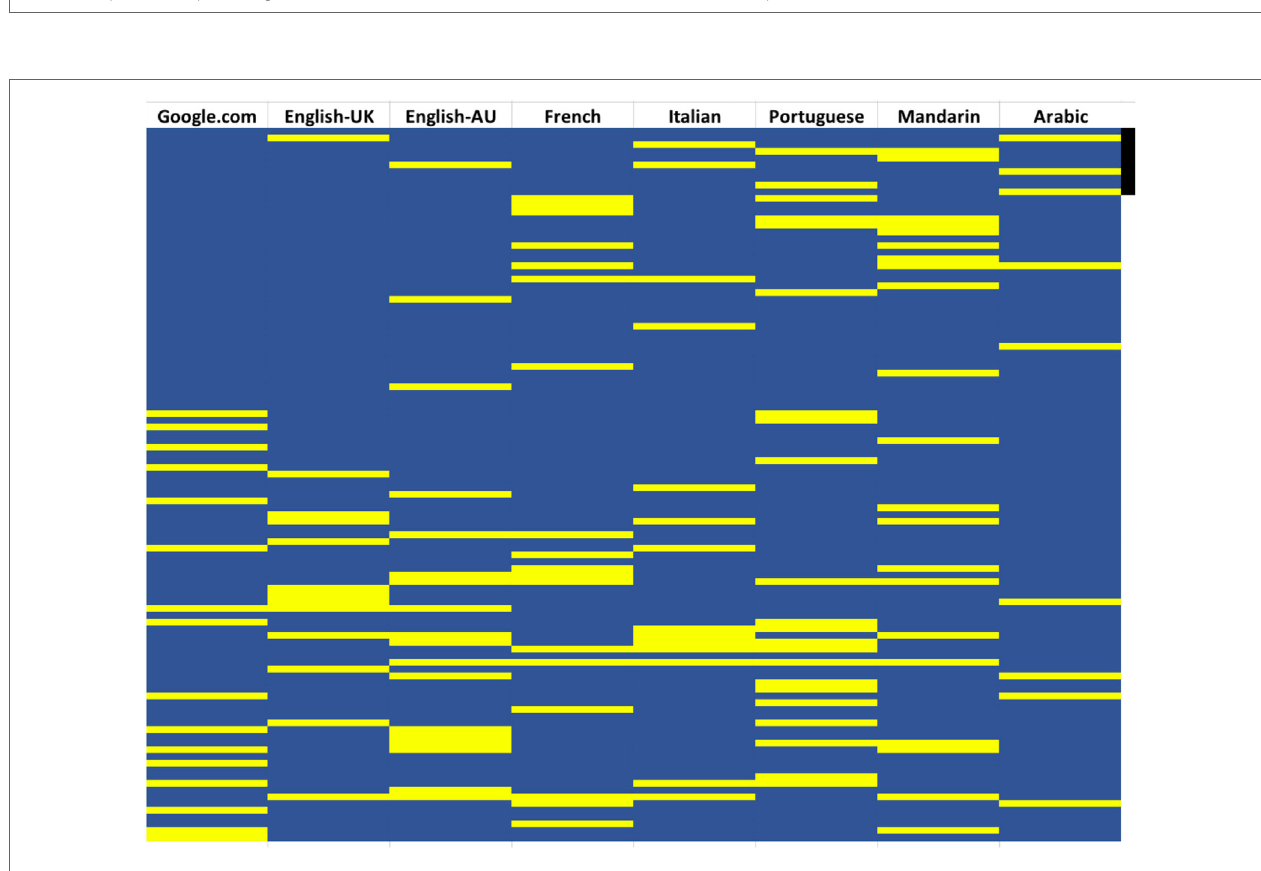
FigUre 3 | Visualization of the ranking of webpages with a negative stance on vaccines in the first 100 websites in each search engine result page (SERP). Webpages are listed in the same order they are ranked in the SERP. Yellow, vaccine-negative websites; blue vaccine-positive or -neutral. The black bar on the right indicate the top 10 webpages.